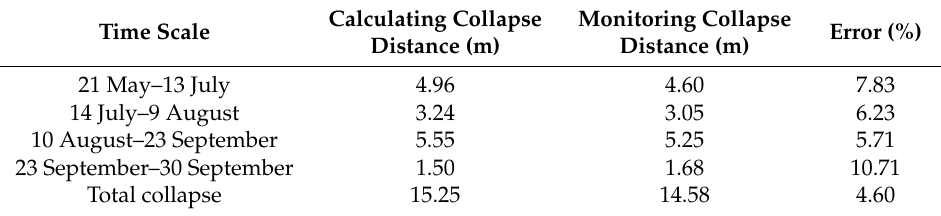
Table 5. Numerical results, field measurements and errors for surveying Section 1 of Figure 1.